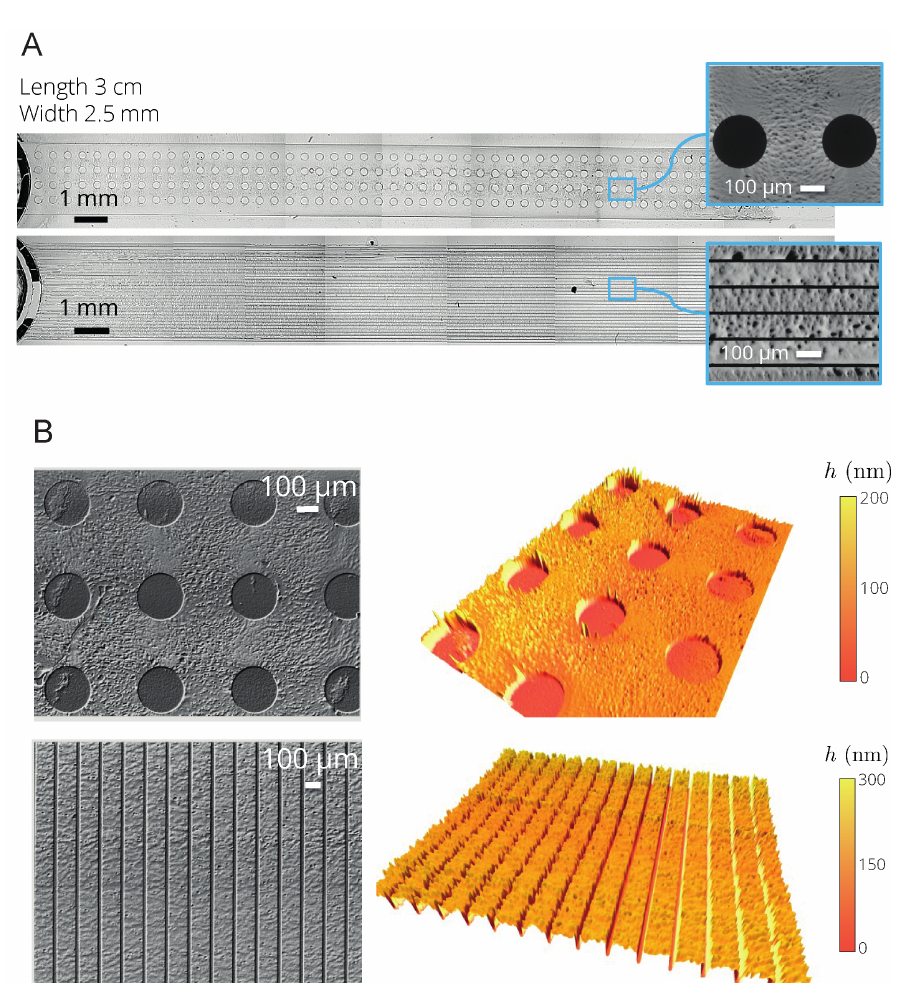
Figure 3. ( A ) Materials engineered with µ -pervaporation made of densely packed CeO 2